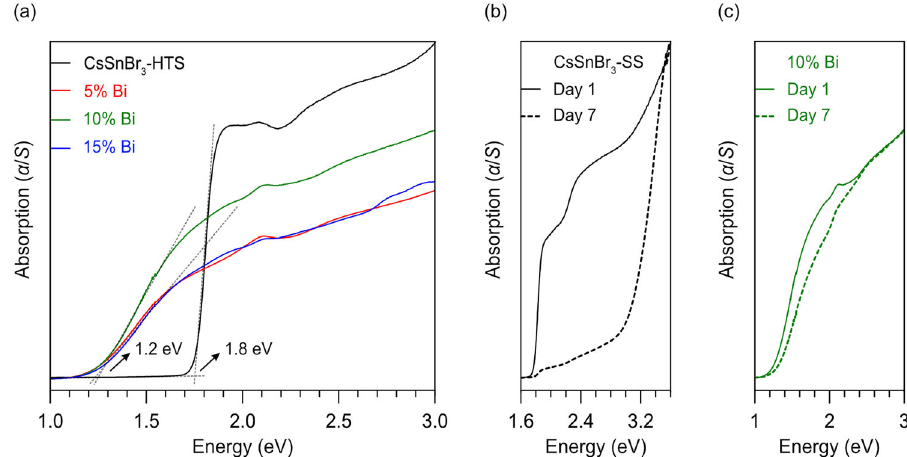
Fig. 4 Optical properties for CsSnBr 3 and Bi-substituted materials. Optical diffuse re fl ectance spectra for a CsSnBr 3 (synthesized at high temperature) and Bi-substituted samples, b CsSnBr 3 (synthesized in solvent), and c 10% Bi-substituted compound (synthesized at high temperature) before and after exposure to a 65% relative